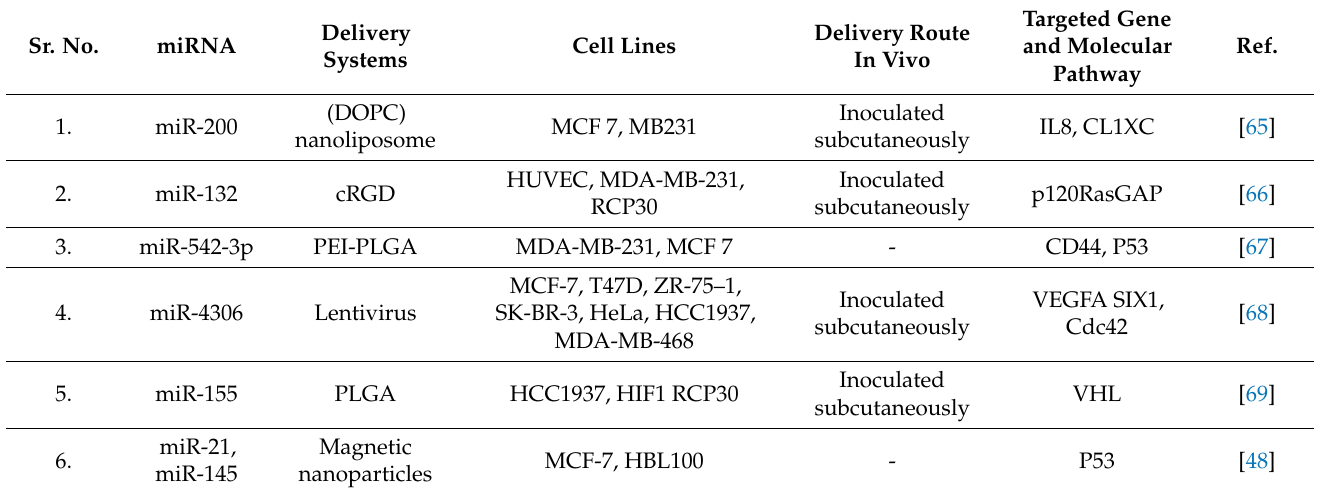
Table 1. Examples of in vivo studies that investigated miRNA-based therapies to target tumor cells in preclinical animal BC models and other cell